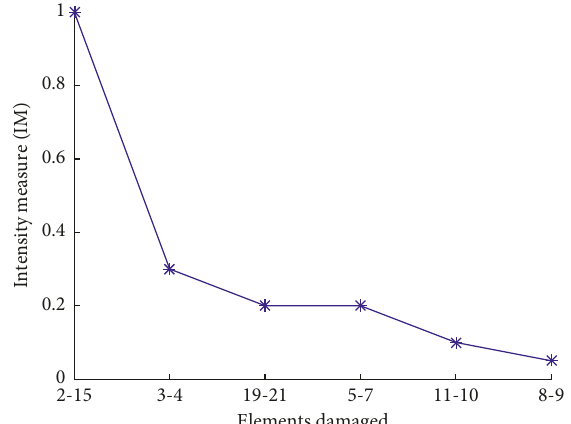
Figure 5: Topology plot of relative IM for all elements.